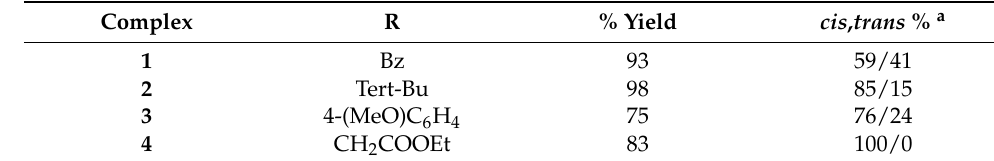
Table 1. Isolated yields and isomeric compositions (CDCl 3 , equilibrium) of [PtBr 2 (PPh 3 )(CNR)].